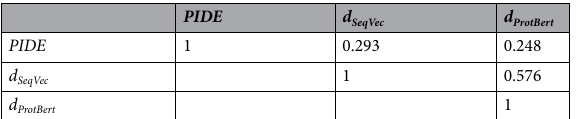
Table 2. Embedding and sequence similarity correlated * . * PIDE percentage pairwise sequence identity, d SeqVec similarity in SeqVec 20 embeddings (Eq. 5); d ProtBert similarity in ProtBert 21 embeddings (Eq. 5). All values represent Spearman’s correlation coefficients calculated for 434,001 sequence pairs. For all pairs, the significance was p -value < 2.2e−16, i.e., significant at the level of the precision of the software R 28 . The similarity between sequence and embeddings correlated less than the two different types of embeddings, namely SeqVec and ProtBert with each other. In order to highlight the trivial symmetry of the matrix, only the upper diagonal was